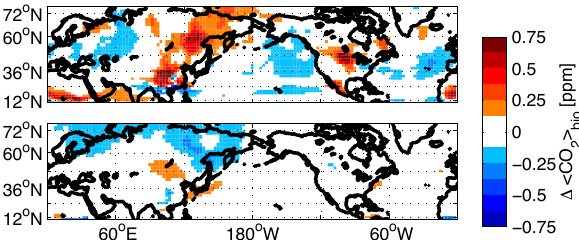
Fig. 18. (a) Difference in August-mean h CO 2 i bio between simula- tions in which CASA fluxes are located above the boundary layer at 700hPa versus at the surface. (b) Same, except for February-mean h CO i 2 bio